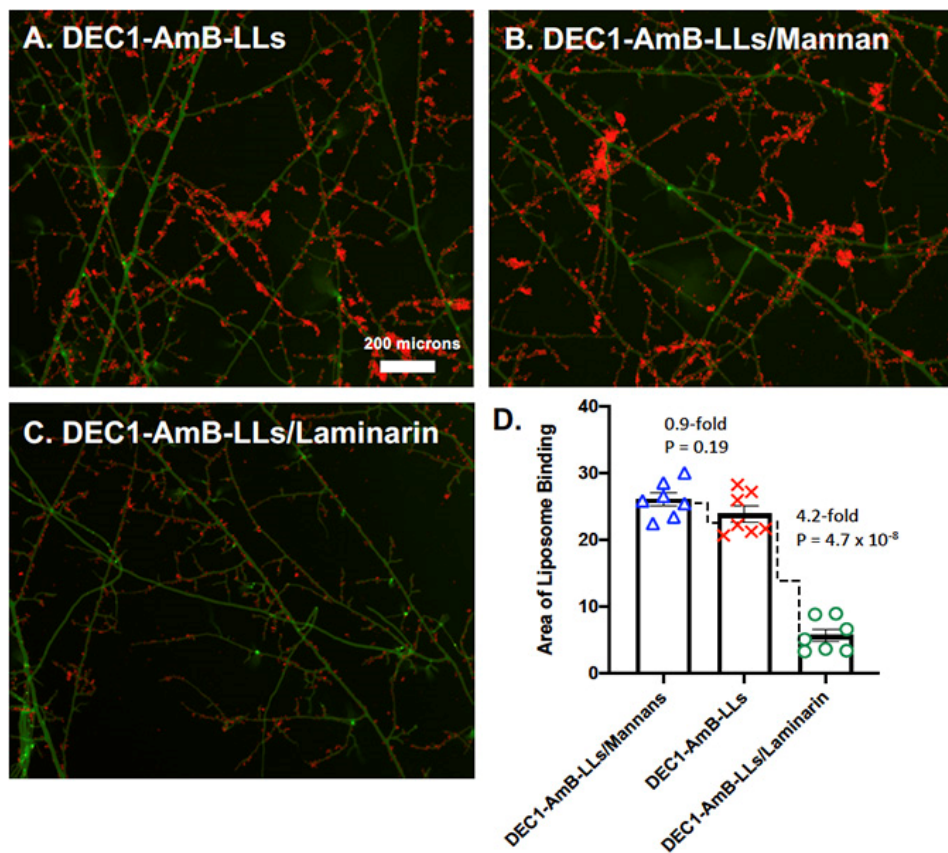
Figure 3. DEC1-AmB-LL binding to R. delemar is beta-glucan-specific. ( A – C ) Representative fluorescence images of R. delemar hyphae (5× magnification) on an agar surface are shown. Hyphae were treated with DEC1-AmB-LLs that had been preincubated either with control buffer ( A ), yeast mannans ( B ), or the beta-glucan laminarin ( C ). The size bar indicates 200 microns. ( D ) The area of red liposome binding (linear plot) was quantified (N = 7). Standard errors and p -values are included.